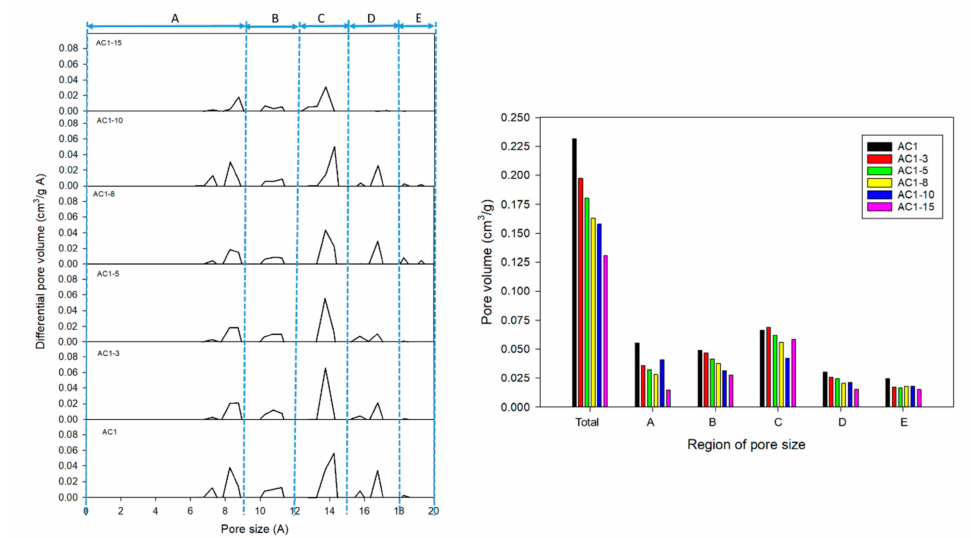
Figure 5. Effect of NaOH loading on the pore size distribution and local pore volume of NaOH